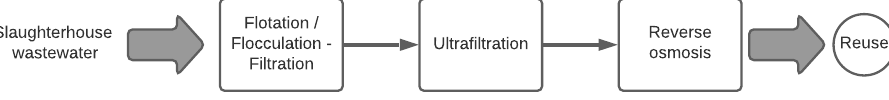
Figure 1. Process flow